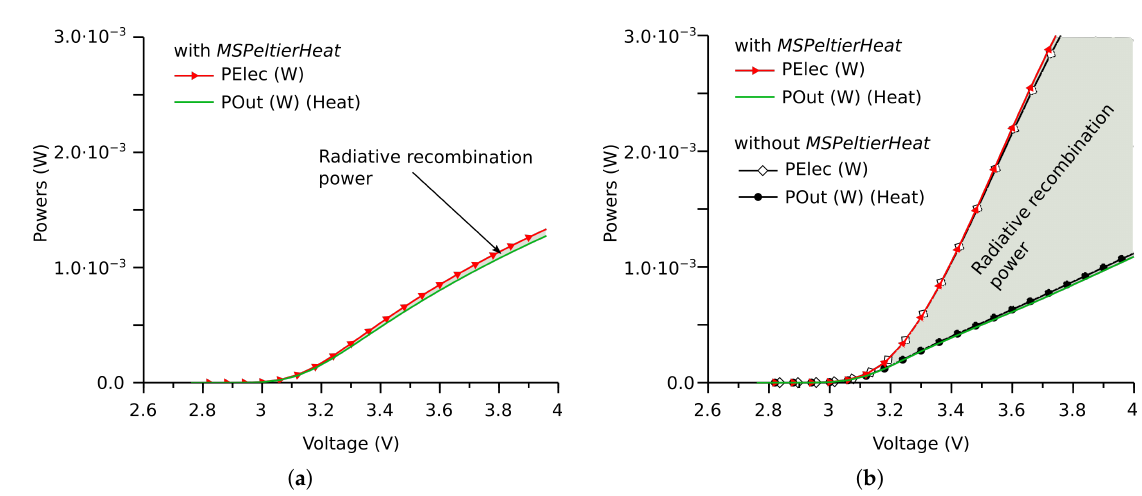
Figure 7. Input and output powers for GaN with radiative recombination model, for structures S1 and S2; structure parameters are: C = 0.5 µ m, P +